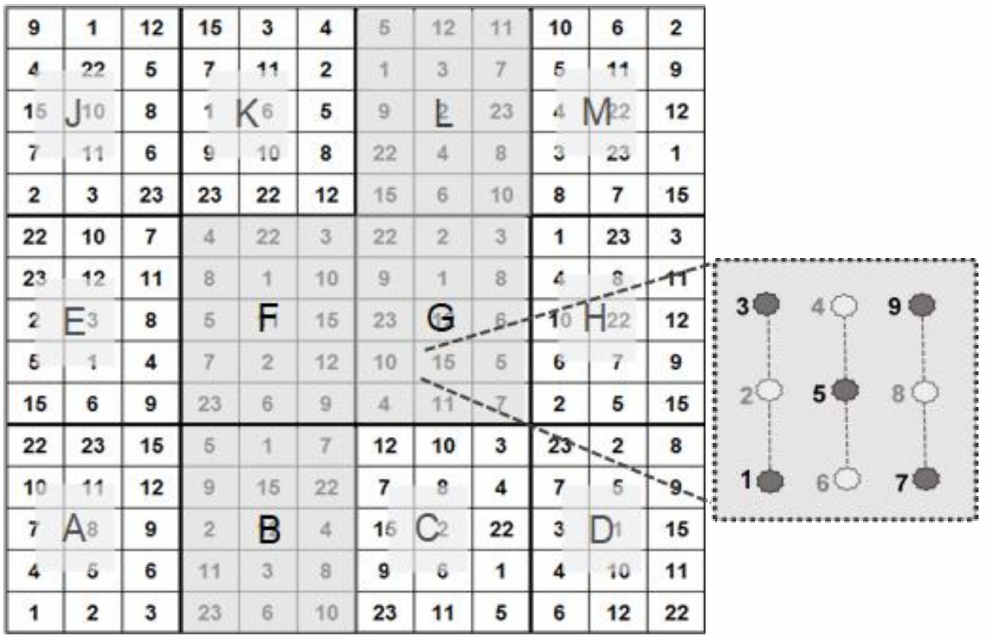
Figure 2. Test design, comprising 4 (B, F, G, L) out of a total of 12 test subplots. Per test unit, 5 out of 9 Robinia test plants were used in our investigations (see